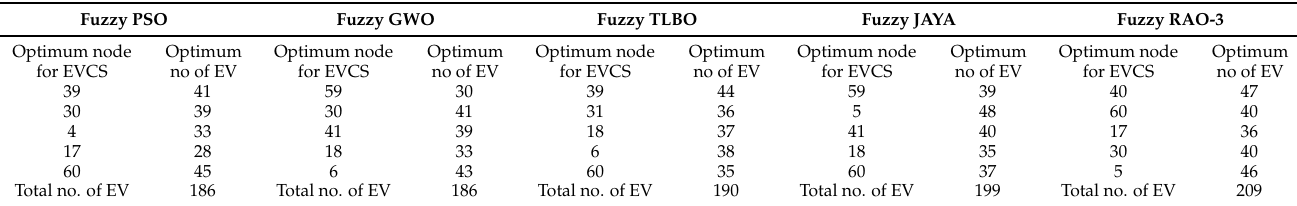
Table 9. Optimum number of EVs and optimum locations of EVCSs.